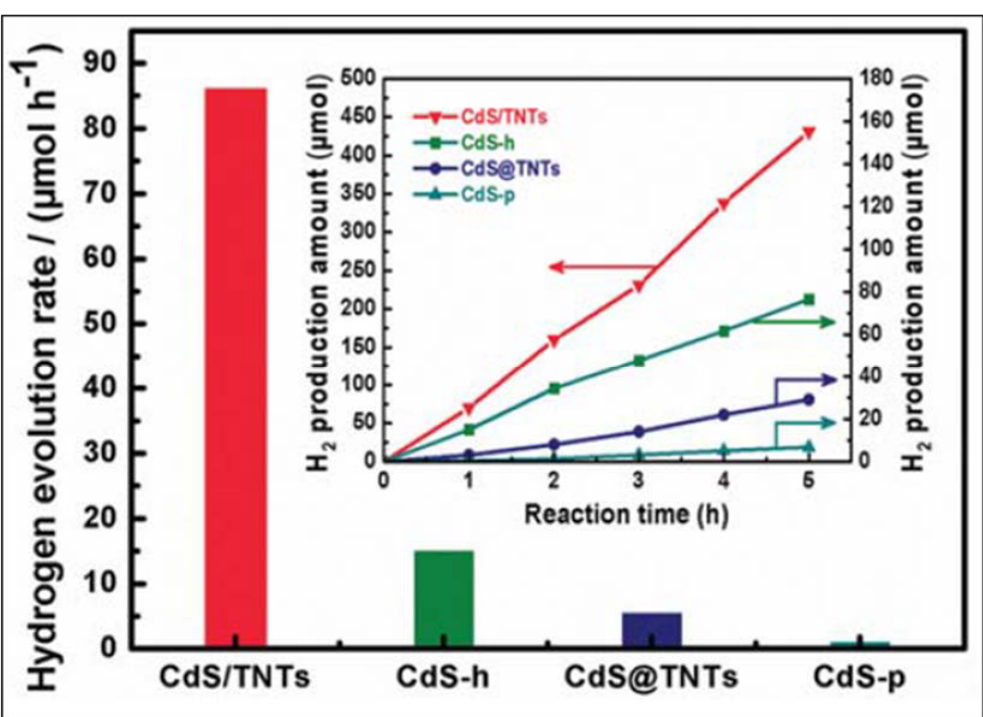
Figure 23. Hydrogen evolution rates over CdS/TNTs, CdS@TNTs, CdS-h and CdS-p. The inset shows their time courses of hydrogen evolution. Reproduced with permission from reference [140].